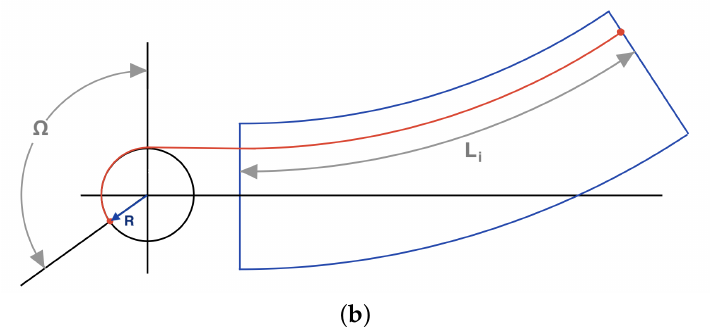
Figure 4. Diagram depicting winch winding based on radius and angle. L o − L i is the distance for tendon winding, and Ω and R are the angle and the radius, respectively. ( a ) Tendon and soft joint prior winch actuation. ( b ) Tendon and soft joint when the winch is operating, with the radius R, and the angle Ω .